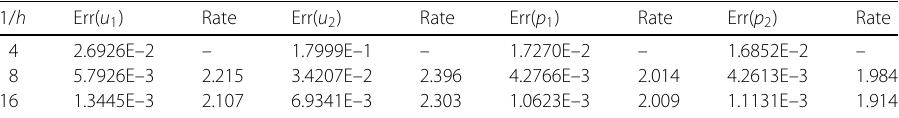
Table 2 Errors for stabilized P 2 – P 2 pair with τ = h 2